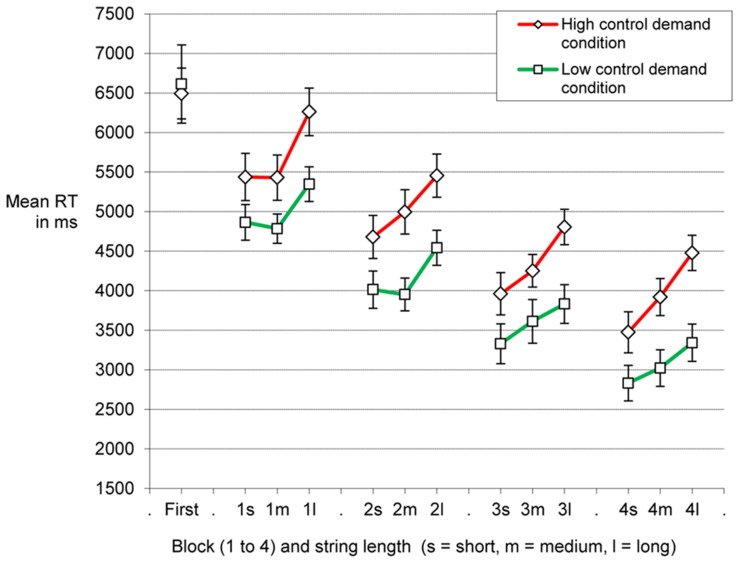
Means of individual median reaction times. On the x-axis, reaction times for short, medium, and long strings (s, m, l) are grouped together by block in order to display the amount of processing of irrelevant information. The impact of string length on RT is stronger in the high control demand condition as compared to the low control demand condition, indicating more processing of the additional letters when information reduction is not possible. Note that error trials as well as RT of trials with violations of the alphabetical order (high control demand condition) were excluded. Note that performance for the two conditions was very similar during the very first trials of Block 1 and quickly diverged afterward. This was evident when we compared (a) the trials of Block 1 that occurred before participants in the high control demand condition encountered the first strings with violation of the alphabetical order outside the letter-digit-letter triplet with (b) the yoked trials of the low control demand condition. As soon as participants in the high control demand condition were confronted with the strings including incorrect prefixes (RT from the latter trials being excluded from main analysis) RT differences between the conditions quickly developed. Error bars: between-subjects standard error of the mean.